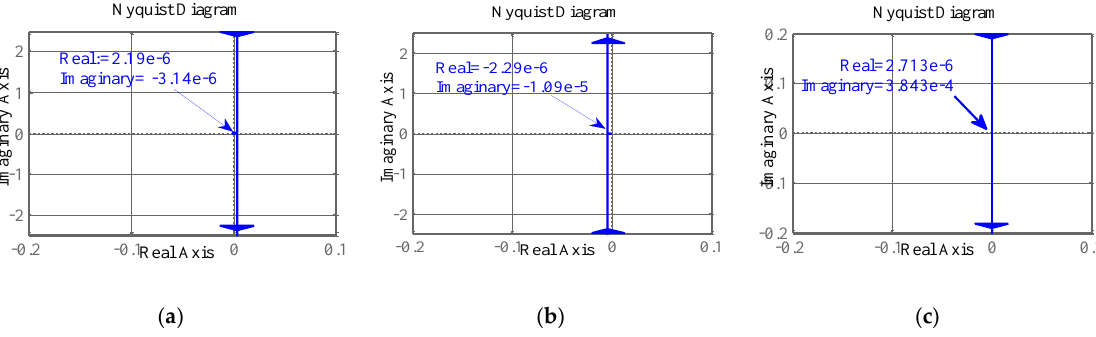
Figure 3. The Nyquist diagram of ∆ i d for constant values of: ( a ) ∆ P m ; ( b ) ∆ P ; ( c ) ∆ v gd . Energies 2018 , 11 , x FOR PEER REVIEW Figure 3 . The Nyquist diagram of Δ i d for constant values of: ( a ) Δ P m ; ( b ) Δ P ; ( c ) Δ v gd .